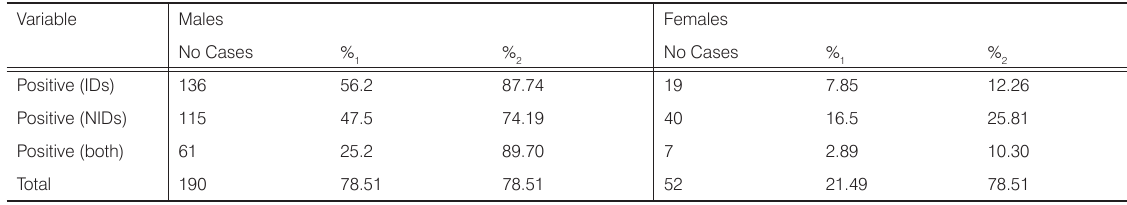
Table 2. Distribution of positive cases according to the sex of the victims.